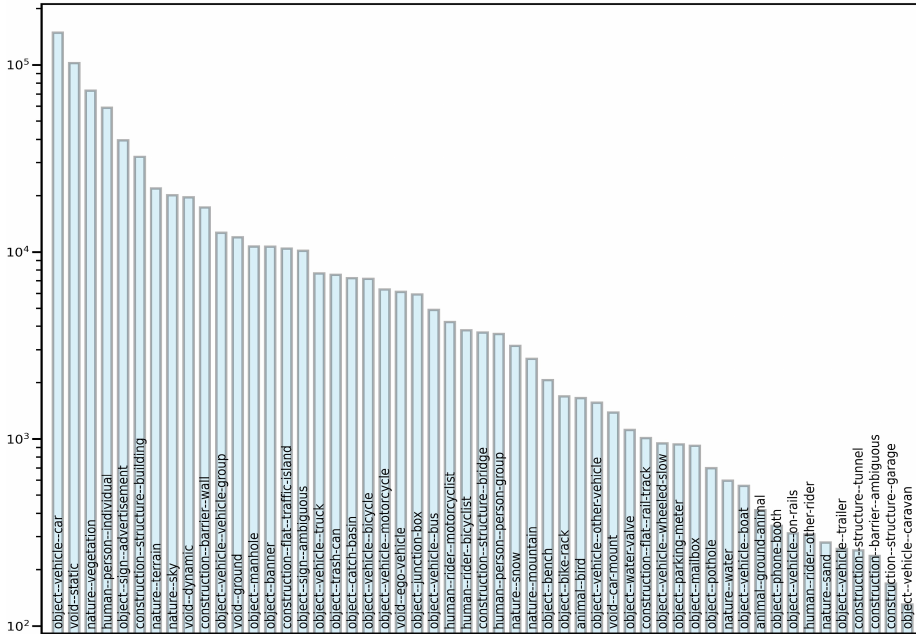
Figure 3. Illustration of removed classes.